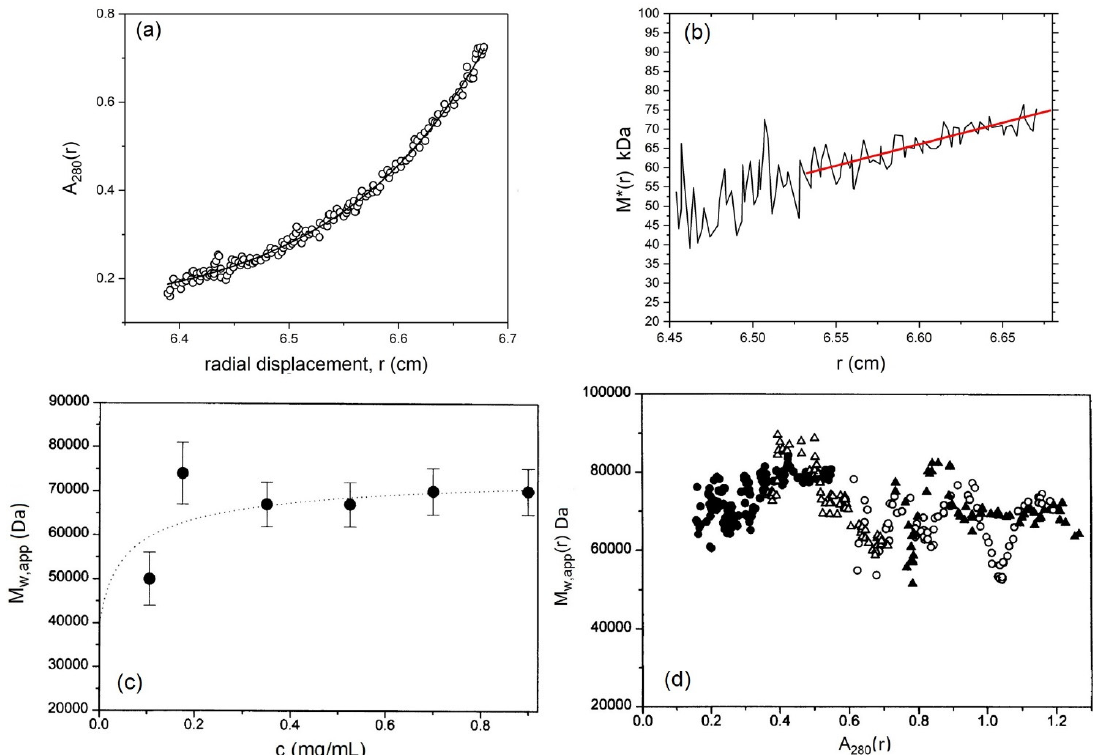
Figure 3. Sedimentation equilibrium characterisation of the cytoplasmic domain of the band 3 transporter protein. ( a ) Concentration distribution (expressed in terms of UV absorbance at 280 nm in a 12 mm optical path length cell) versus the radial displacement at a given position in the cell. Equilibrium speed 10,000 rpm (~ 8000 g, depending on radial position), temperature 20.0 ◦ C, loading concentration c = 0.18 mg/mL. The line fitted is for an ideal reversible dimerization with a molar dissociation constant K d = (2.8 ± 0.5) µ M ( b ) Obtaining the apparent weight average molecular mass M w,app for the whole distribution of macromolecular components. The integral function M * [43] is used which yields M w,app over the whole distribution when r reaches the cell base position (indicated by the red line extrapolation). Same conditions is in ( a ). At low loading concentrations (such as the case here) M w,app = M w , the thermodynamically ideal weight average molecular mass. ( c ) Plot of apparent weight average molecular mass versus cell loading concentration, c . The dotted curve is a fit for an ideal reversible dimerisation with dissociation constant, K d ~3 µ M, in agreement with ( a ). ( d ) “Point” apparent weight average molecular masses M w,app ( r ) at individual points or radial positions in the ultracentrifuge cell plotted against local concentration A ( r ) in absorbance units at 280nm for different loading concentrations (different symbols). Adapted from Cölfen et al. [11] and reproduced by permission of The Biophysical